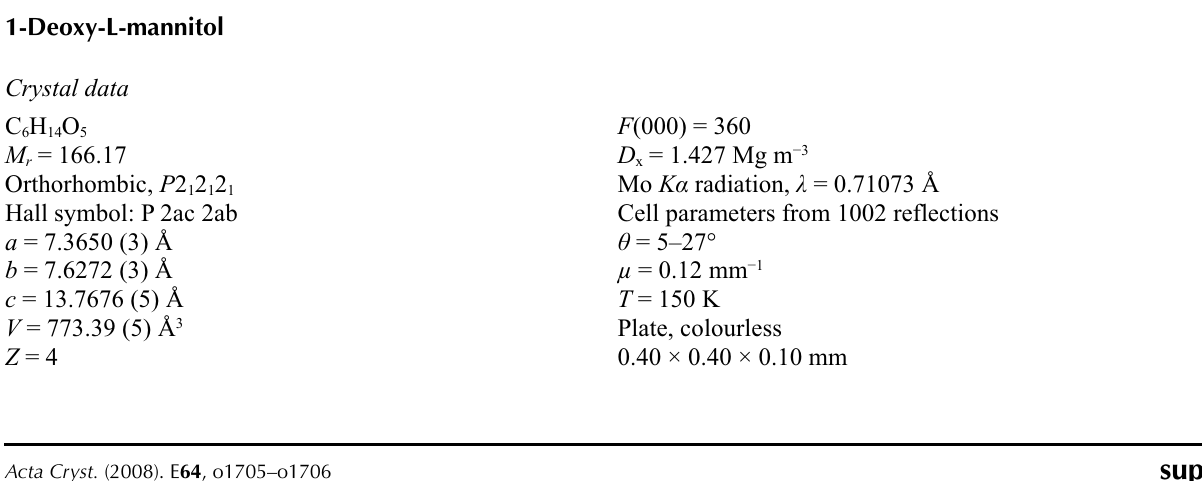
Packing diagram for the title compound projected along the b axis. Hydrogen bonds are shown as dotted